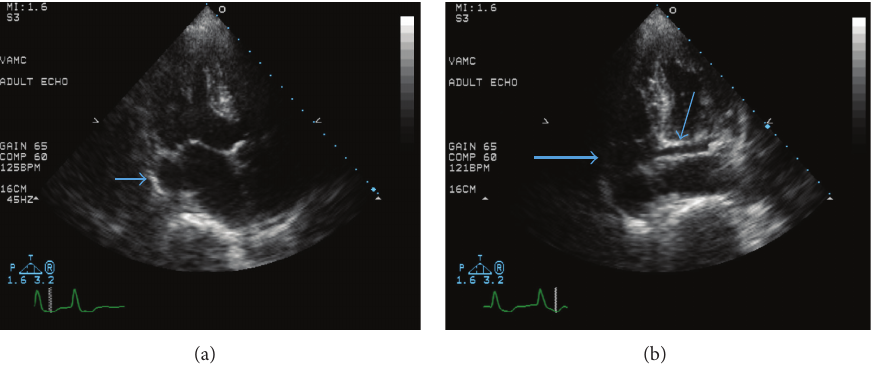
Figure 3: (a) Echocardiogram showing an off-axis longitudinal view of a portion of the persistent left superior vena cava (arrow) traversing under the left atrium on its course to the coronary sinus. (b) Echocardiogram showing an off-axis cross-sectional view of persistent left superior vena cava (large arrow) before it terminates in the dilated coronary sinus (small